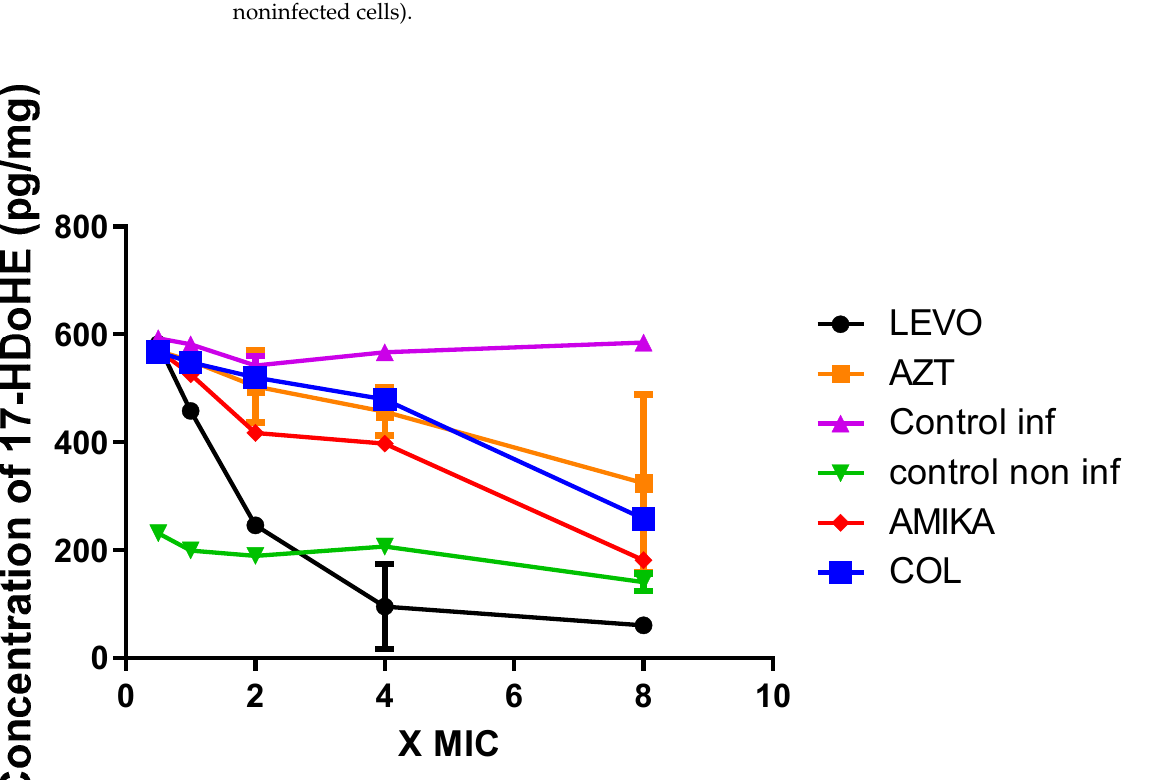
Figure 5. Concentration of 17-HDoHE (pg/mg of protein) in extracts of human lung epithelial NCI-H292 cells non-infected and treated with antibiotics, 24 h. (LEVO = levofloxacin, AZT = aztre- onam, AMIKA = amikacin, COL = colistin, Control inf = control in infected cells, Control non-inf = control in noninfected cells)